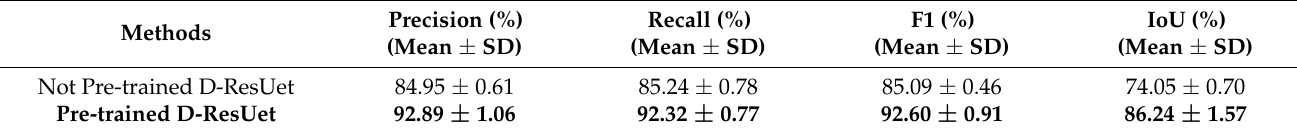
Table 7. The Precision, Recall, F1, and IOU of the models (Mean ± SD 1 ).